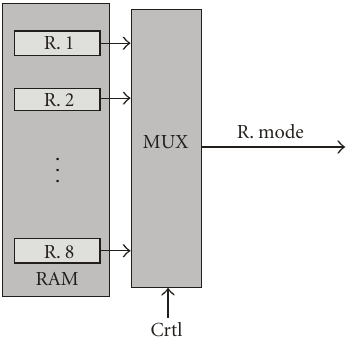
Figure 18: Block diagram of the SW-CU.